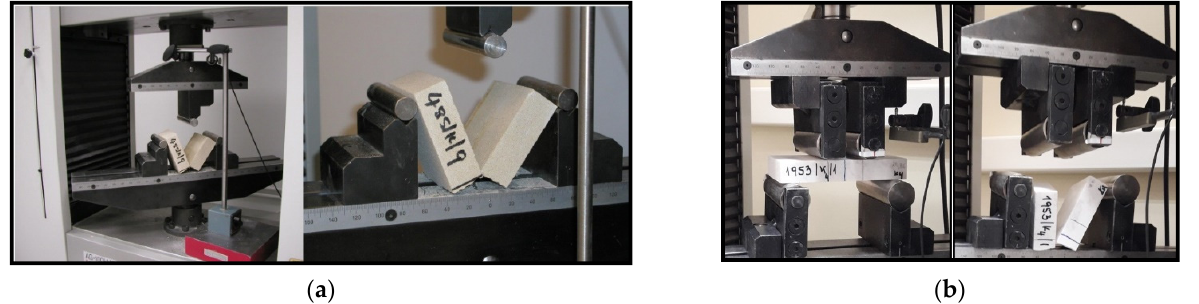
Figure 1. Flexural strength test: ( a ) under a concentrated load (FS 3 ); ( b ) under a constant moment (FS 4 ).